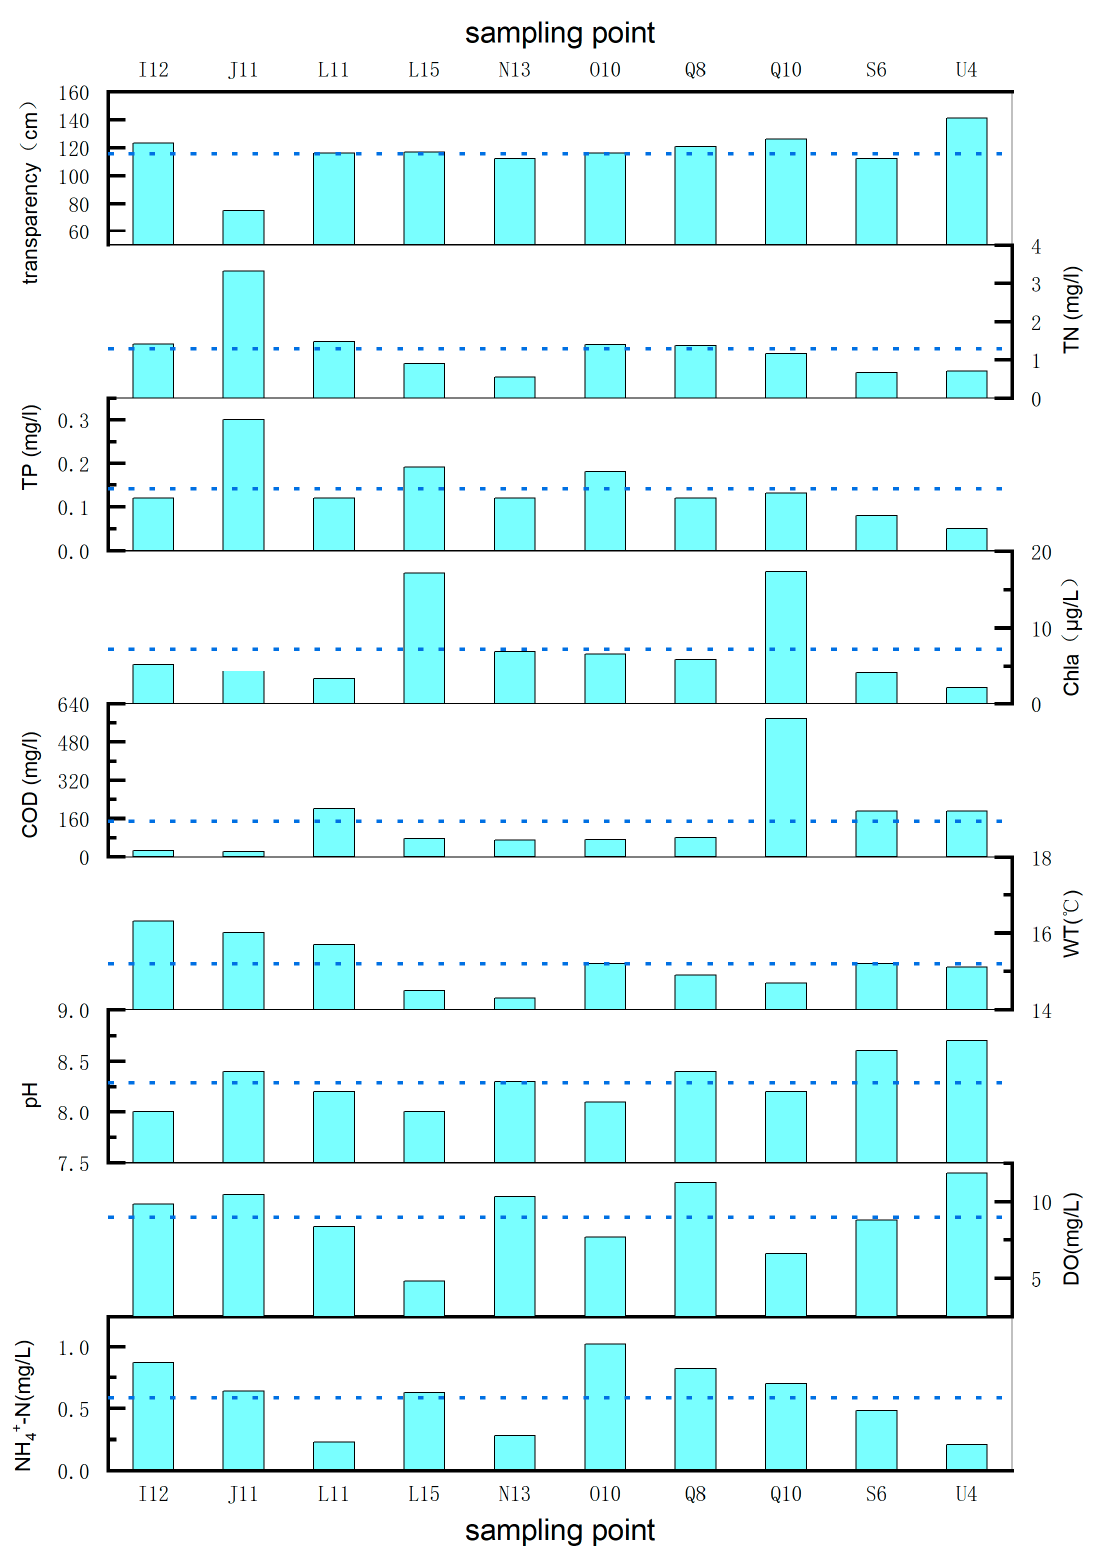
Figure 2. Variation characteristics of typical physical and chemical indexes in Wuliangsuhai Lake (the dotted line shows the average value).